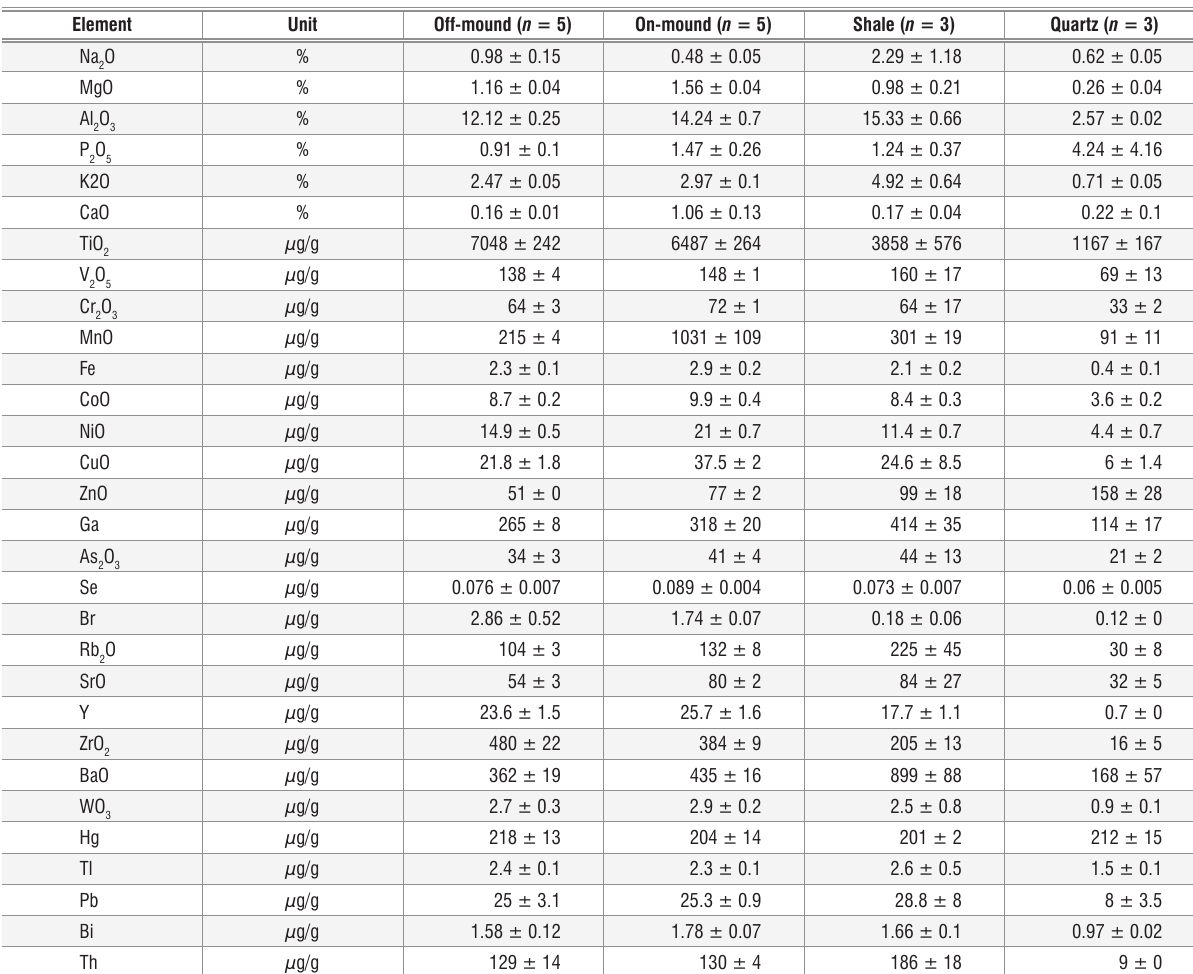
The correlation between the shale elemental composition and the elemental composition of on- and off-mound soil. The grey band indicates the 95% confidence interval. The slope, intercept and Pearson correlation coefficient are shown. The element positions are identified by their symbols and include Na, Mg, Al, P, K, Ca, Ti, V, Cr, Mn, Fe, Ni, Cu, Zn, Ga, As, Se, Br, Rb, Sr, Y, Zr, Ba, W, Hg, Tl, Pb, Bi and Th. The elemental concentrations of the off- and on-mound soils (averaged across all depths) with shale and quartz rock collected from the study site. The values are the mean ±